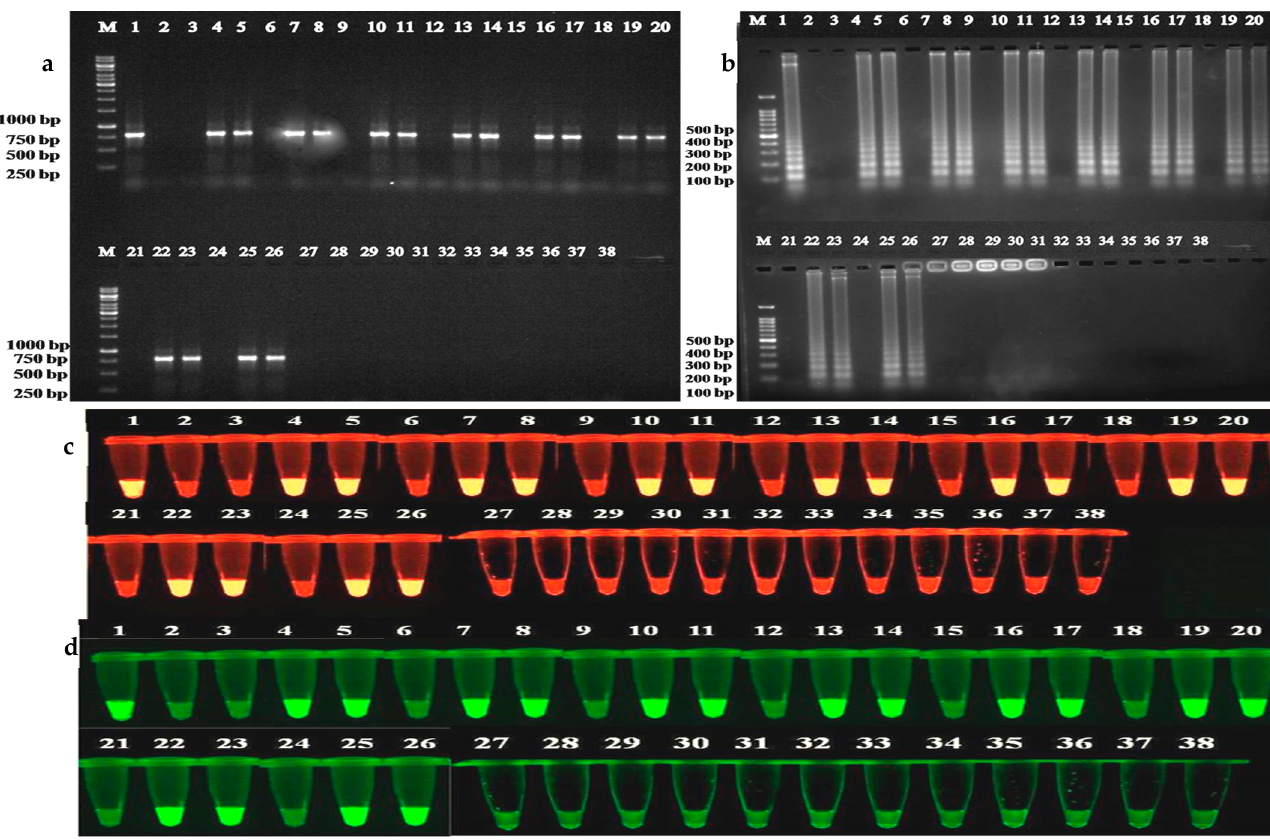
Figure 6. Immunocapture assays for samples from various host plants suspected to be infected with begomoviruses and their visualization on agarose gel using dyes ( a ) IC-PCR, ( b ) IC-LAMP, ( c ) EtBr, and ( d ) VeriPCR dyes. Lane M: 1 kb DNA marker; Lane 1: Positive control (Infected ridge gourd);